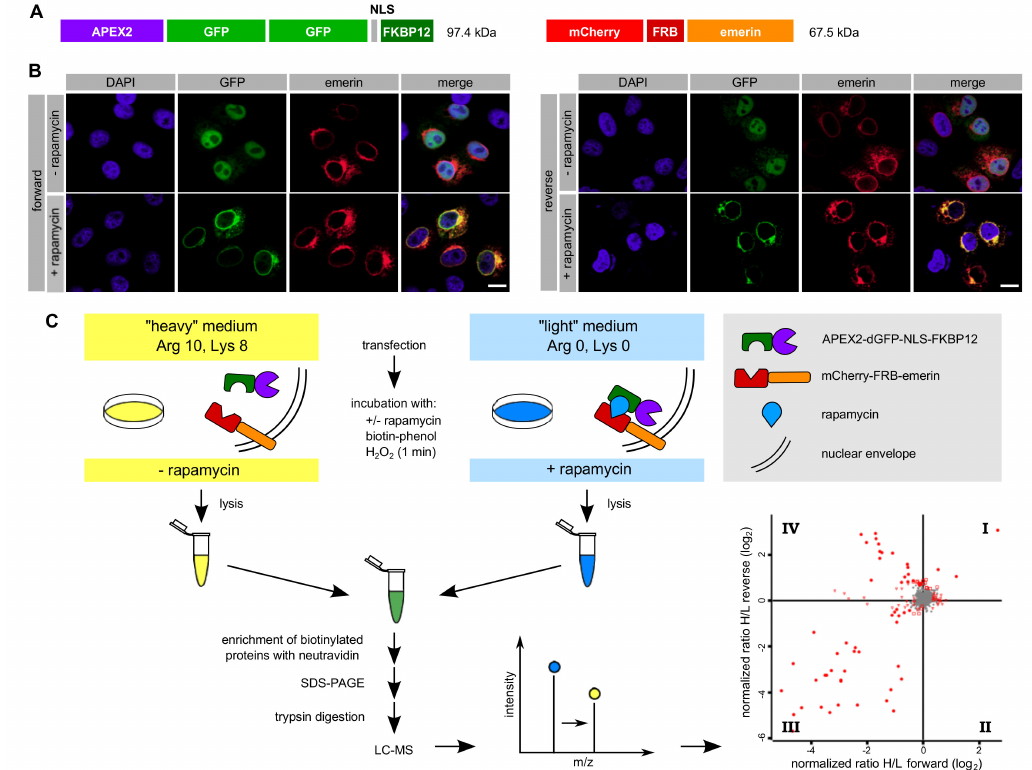
Figure 3. Proximity mapping of emerin by RAPIDS. ( A ) Scheme of APEX2-dGFP-NLS-FKBP12 and